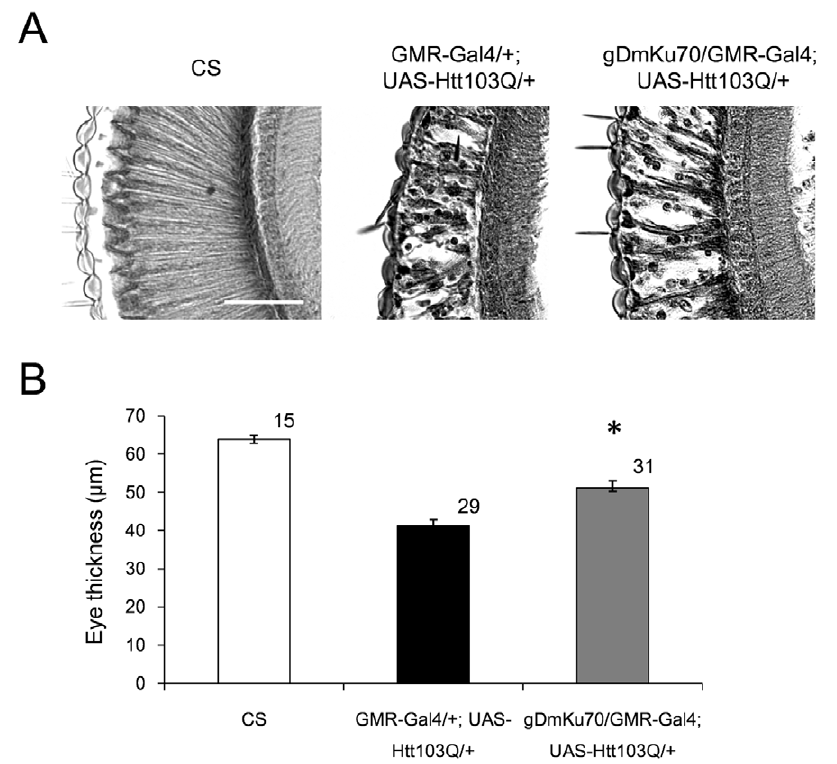
Figure 2. Drosophila homologue of Ku70 (DmKu70) has a protective effect invivo against the toxicity of mutant Htt. (A) Axial sections of the Control Canton-S, GMR-Gal4/ + ;UAS-Htt103Q/ + and GMR-Gal4/ + ;gDmKu70/UAS-Htt103Q fly eyes are shown. The vacuolar degeneration was severer than that in Figure 2. In triple transgenic flies generated by mating GMR-Gal4/UAS-Htt103Q flies with UAS-mouse Ku70 flies, Ku70 co- expression partially recovered degeneration. Scale bar, 50 m m. (B) Quantitative analysis of the eye thickness of each transgenic fly. The numbers above each bar indicate the number of counted flies. Mean + / 2 SE. *: p , 0.01, Student’s t -test. All flies tested were female. Number of flies used for the experiments are indicated on the shoulder of each bar. The genetic background was w (CS10) in this